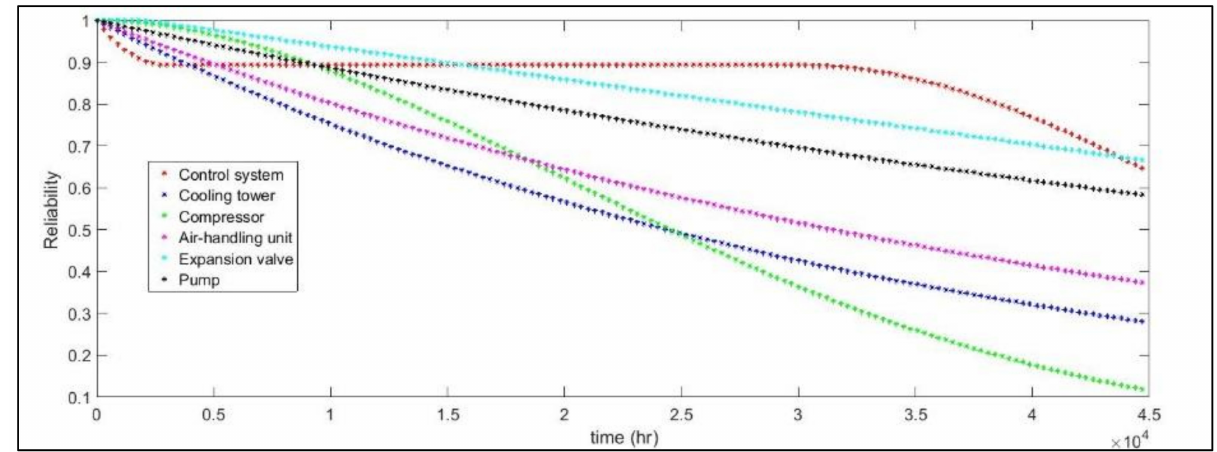
Figure 3. The reliability curve for some of the components in the system.